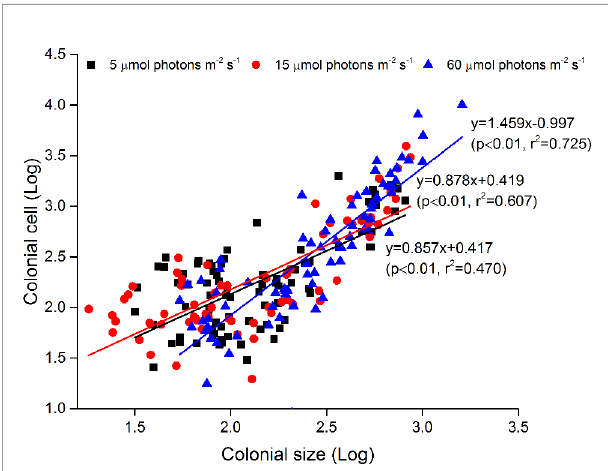
FIGURE 3 | Relationships between colony size (log) and the number of colonial cells per colony (log). Data were obtained at the end of diploid culture experiments.